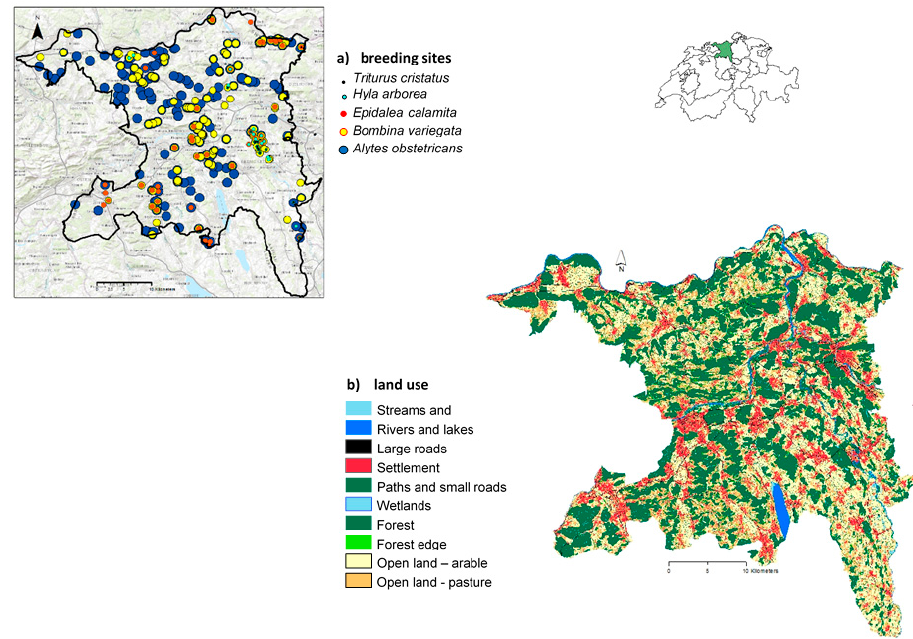
Figure 1. ( a ) locations of observed breeding sites from within the last 10 years for each species. In total, there were 12 T. cristatus , 26 H. arborea , 45 E. calamita , 126 B. variegata , and 211 A. obstetricans breeding populations. The figure in the upper right shows the position of the canton of Argau within Switzerland. Basemap source: Esri, HERE, DeLorme, TomTom, Intermap, increment P Corp., GEBCO, USGS, FAO, NPS, NRCAN, GeoBase, IGN, Kadaster NL, Ordnance Survey, Esri Japan, METI, Esri China (Hong Kong), swisstopo, MapmyIndia, © OpenStreetMap contributors, and the GIS User Community; ( b ) land cover and land use data of the study region (Kanton Aargau) in raster format with a cell size of 10 m 2 .